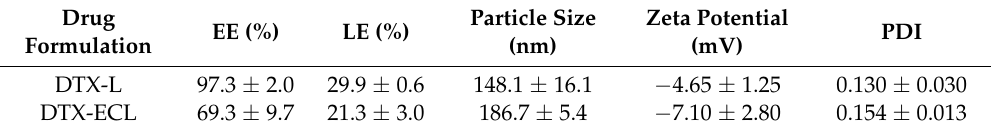
Table 1. Characteristics of DTX-L and DTX-ECL.